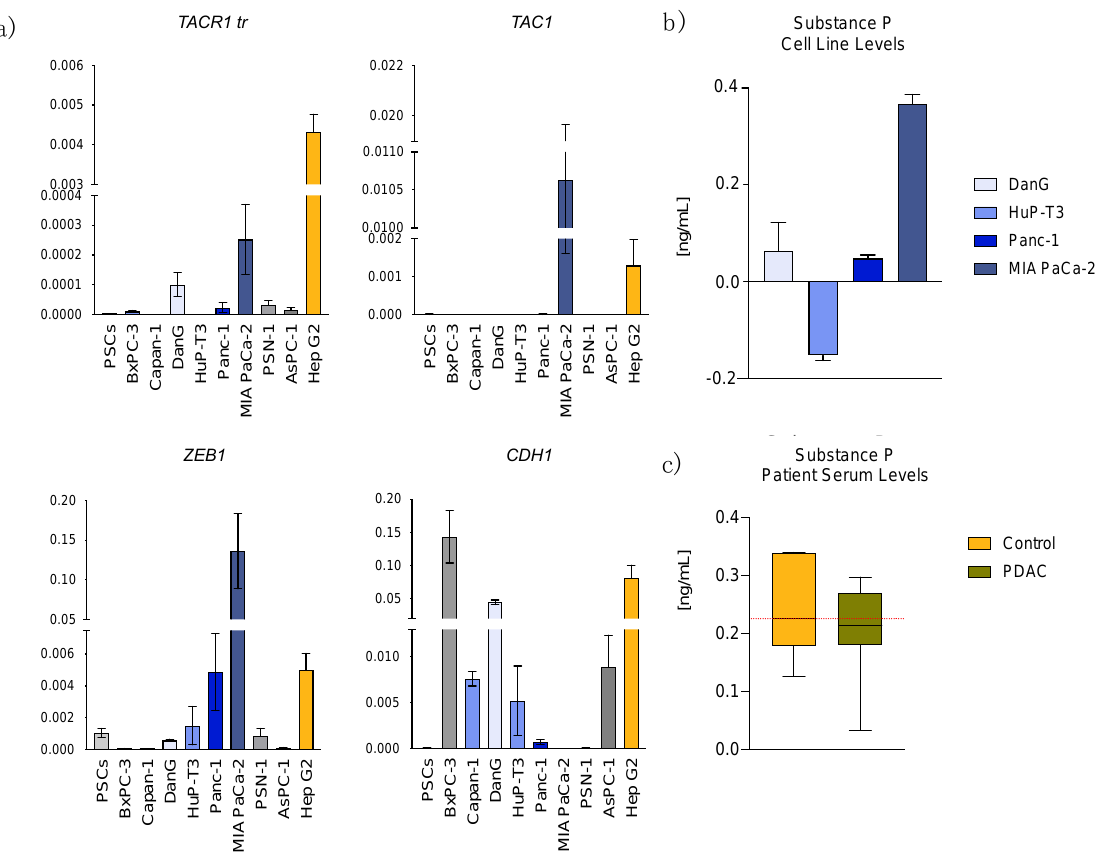
Figure 1. Expression of the SP/NK1R complex varies in established cell lines and PDAC patient serum. ( a ) Transcript abundance analyzed through RT-qPCR illustrated in ∆Ct with standard deviation (SD) in the indicated cell lines. ( b ) ELISA for quantitative analysis of Substance P levels in PDAC cell lines and ( c ) serum of control ( n = 7) vs. PDAC patients ( n = 7).